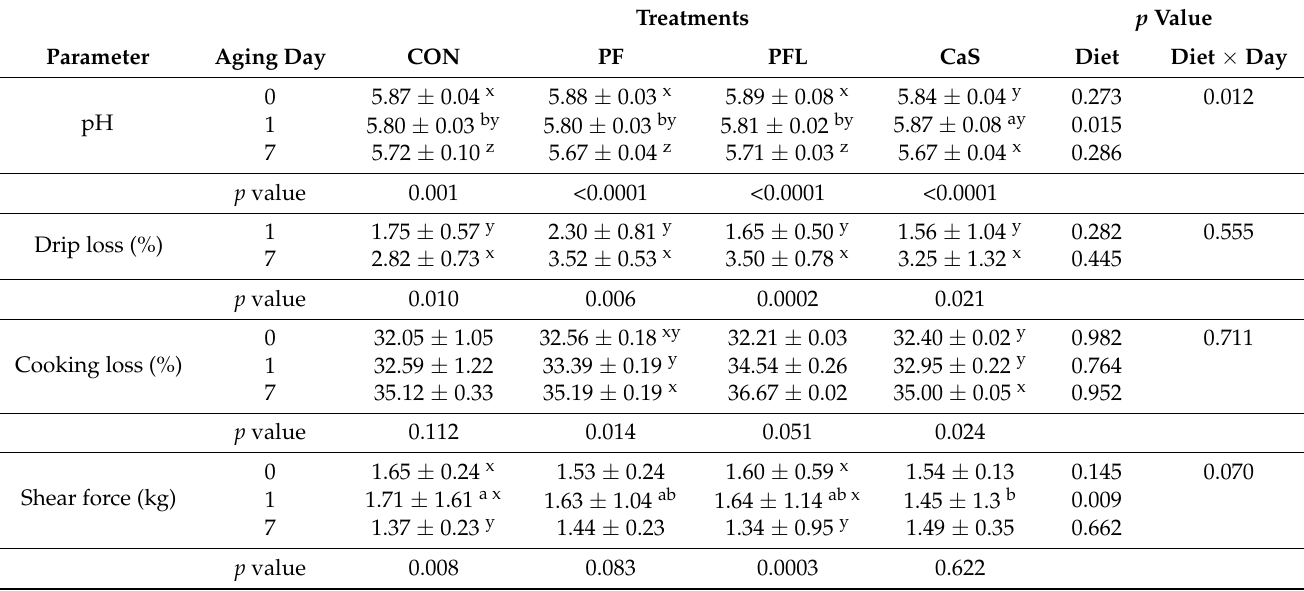
Table 3. Physical characteristics of longissimus dorsi muscle of Dorper sheep at different aging days. Treatments p